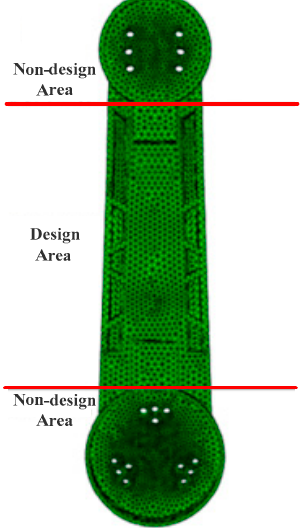
Figure 15. Design area and non-design area.